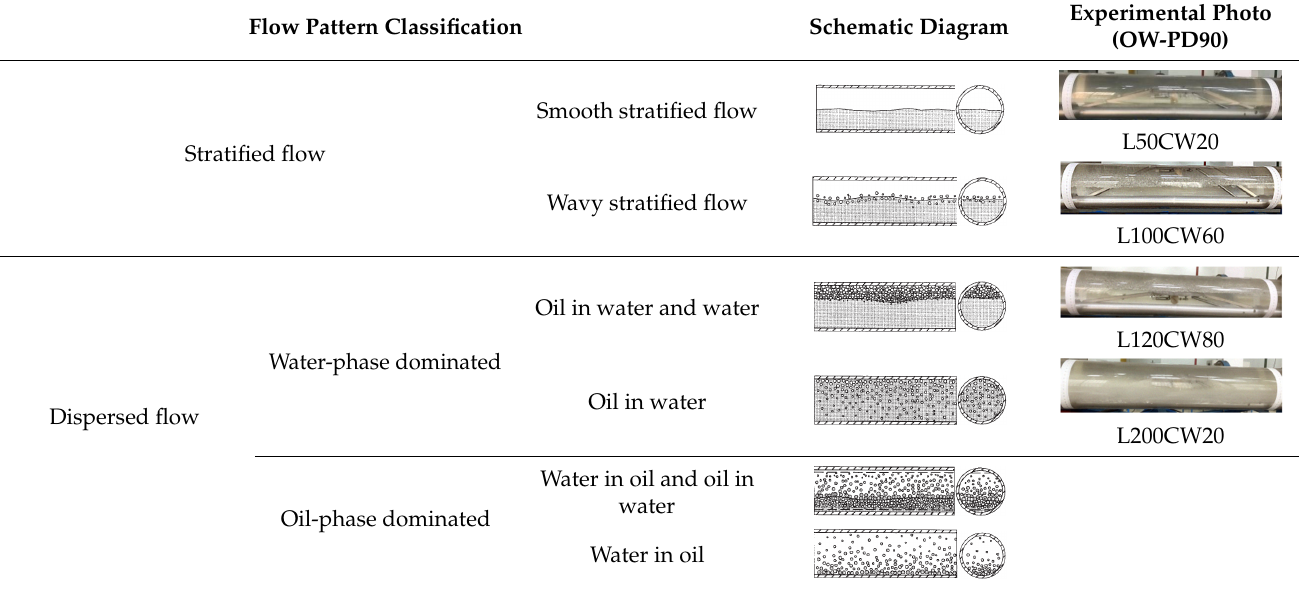
Table 1. Trallero et al.’s horizontal-pipe oil–water flow pattern classification. OW represents the oil-water, PD represents the wellbore deviation angle, L represents the total flowrate of oil and water, and CW represents the water cut.